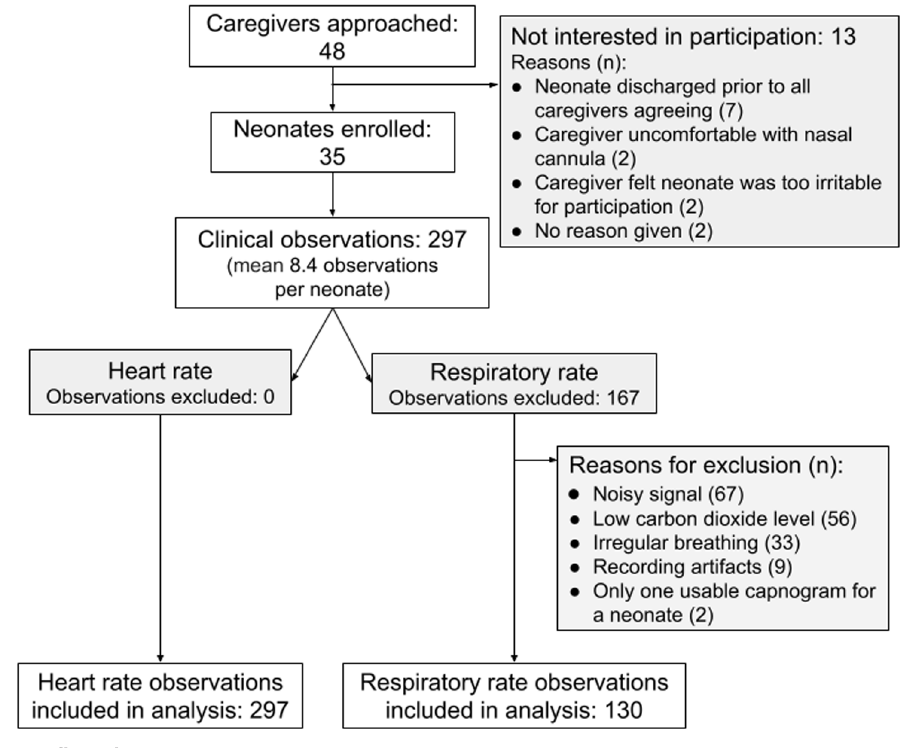
Figure 1. Recruitment flow